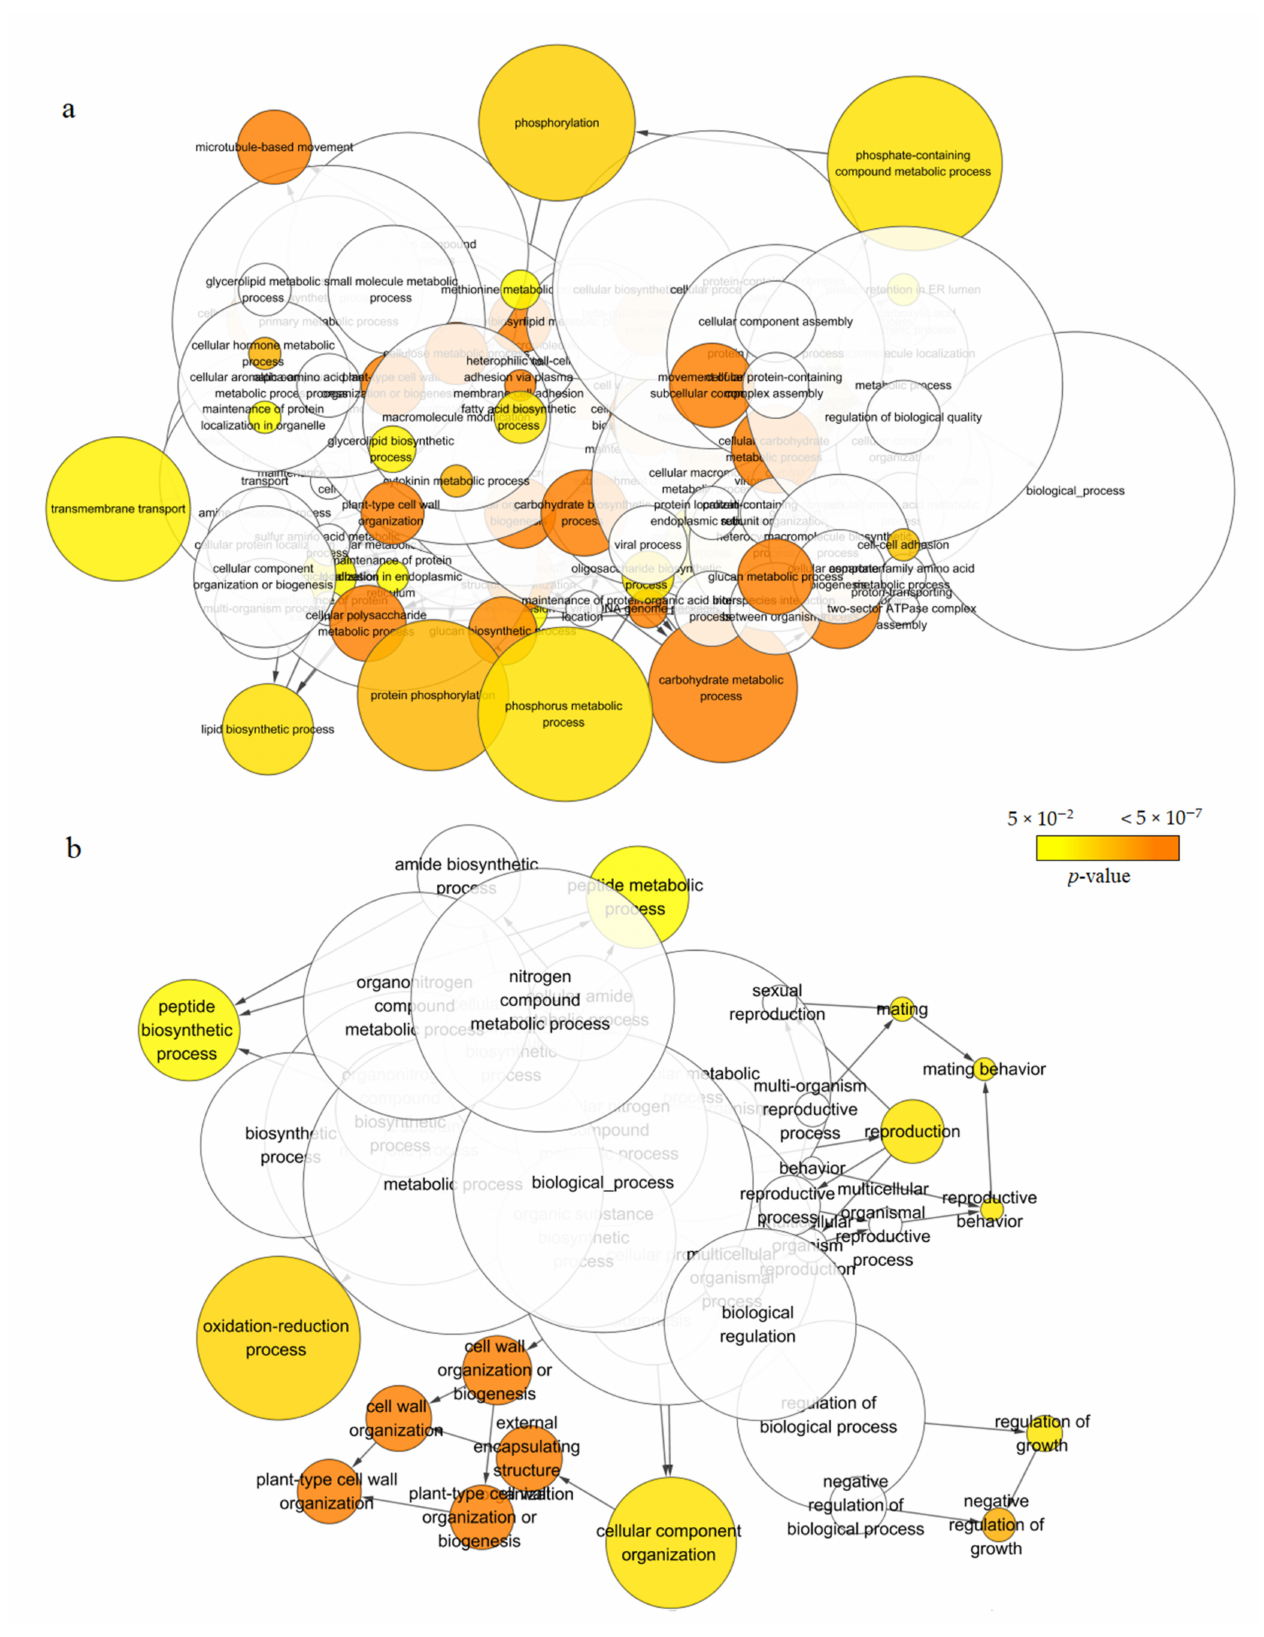
Figure 4. The “biological process” category of Gene Ontology (GO) enrichment analysis of tissue-specific expressed genes. ( a ) male cone; ( b )